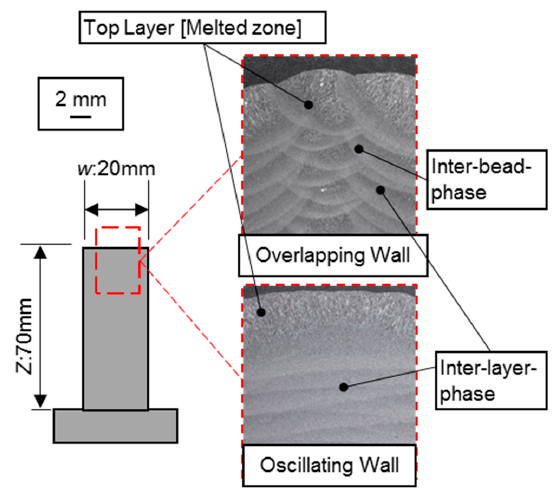
Figure 7. Macrography analysis of the layers disposal at the top of the walls in both strategies.